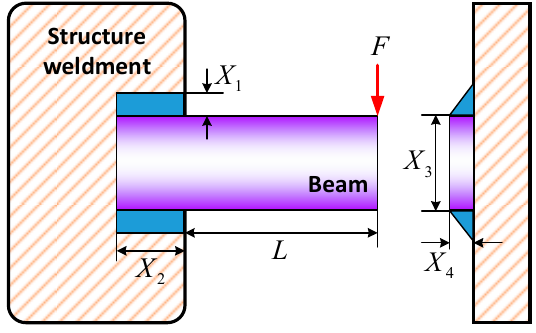
Figure 9. A welded beam structure.